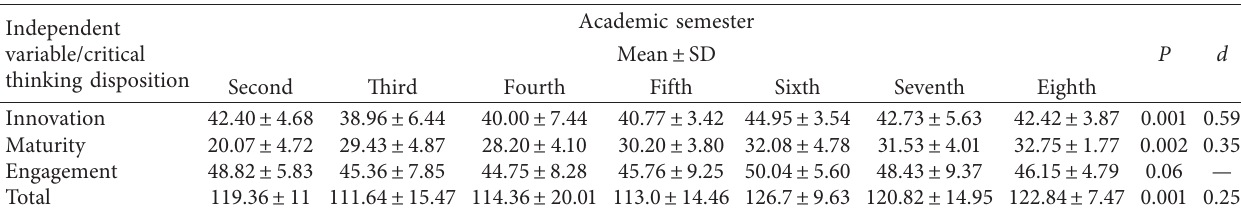
Table 3: Total score of critical thinking disposition and scores of its dimensions in different semesters.